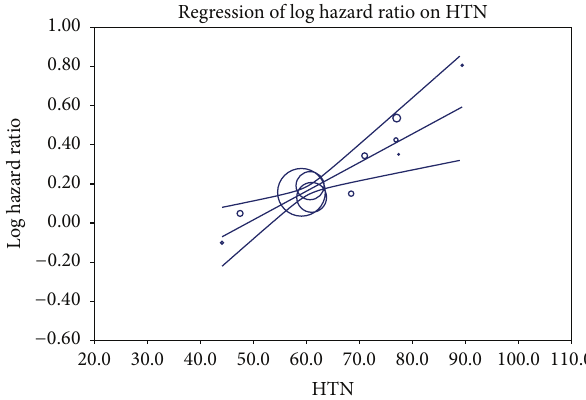
Figure 5: Effect of percentage of hypertensive patients in individual studies on mortality risk of digoxin using a multivariate metare- gression model including hypertension, heart failure, and previous stroke; increased percentage of patients with hypertension on the 𝑥 - axis correlated with increased HR on the 𝑦